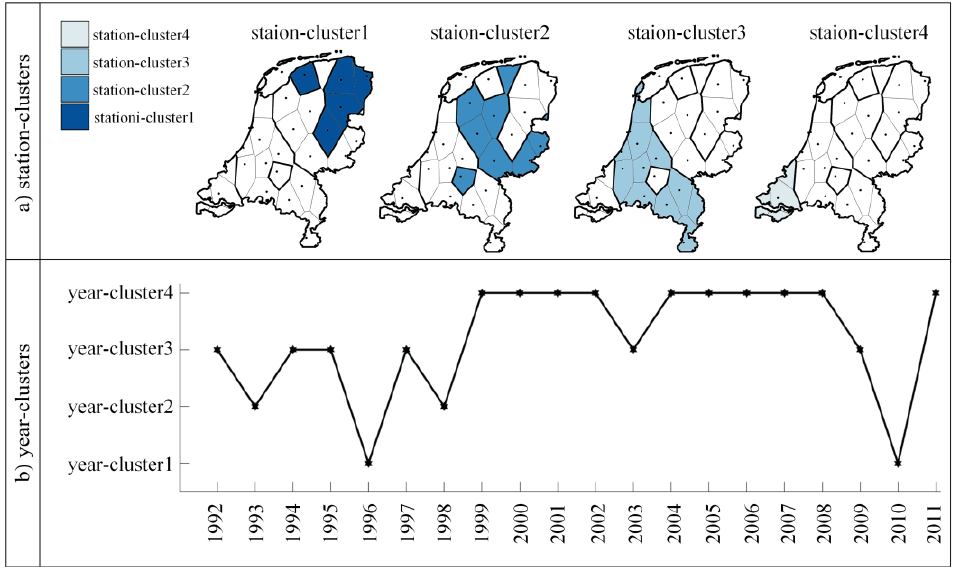
Figure 5. Spatio-temporal clusters (( a ) station-clusters; ( b ) year-clusters) identified in Dutch temperature data at the daily resolution. data at the daily